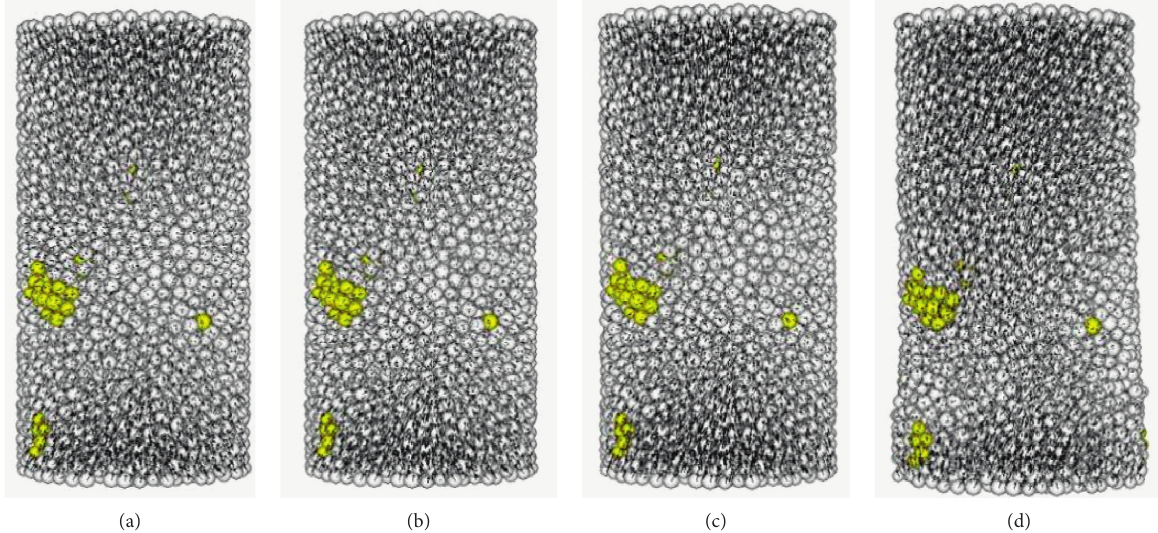
Figure 12: Displacement vectors of different load/unload state: (a) first cycle step, (b) second cycle step, (c) third cycle step, and (d) final damage.